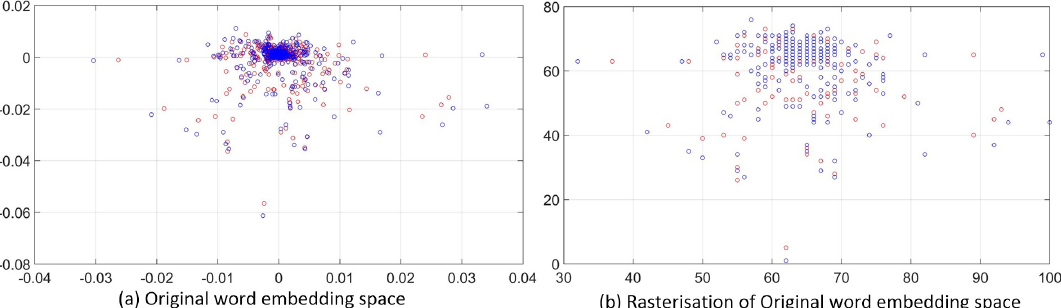
Figure 6. The generated word embedding space ( a ); and its rasterization ( b ). A total of 3832 words was used, and each word was represented by a pair of red and blue points.